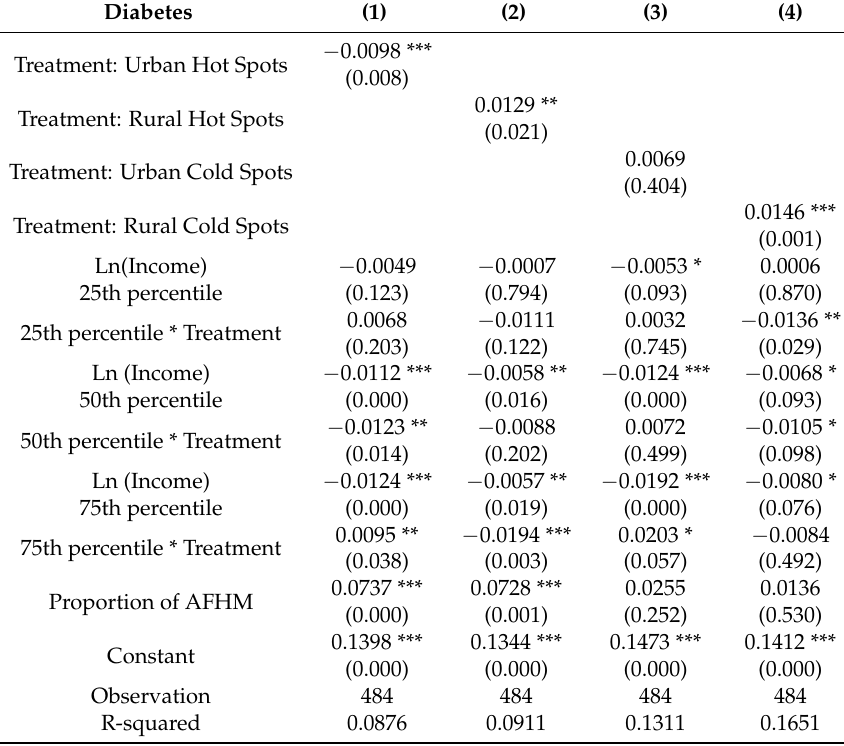
Table A7. Kernel matching results for